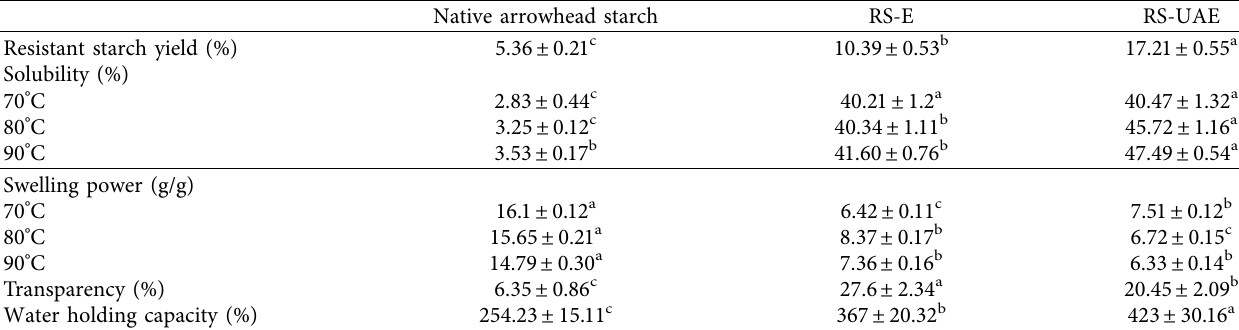
Table 1: Changes in swelling power, water holding capacity, solubility, and transparency. RS3-E type 3 resistant starch prepared by traditional-enzymolysis; RS3-UAE type 3 resistant starch prepared by ultrasound-assisted